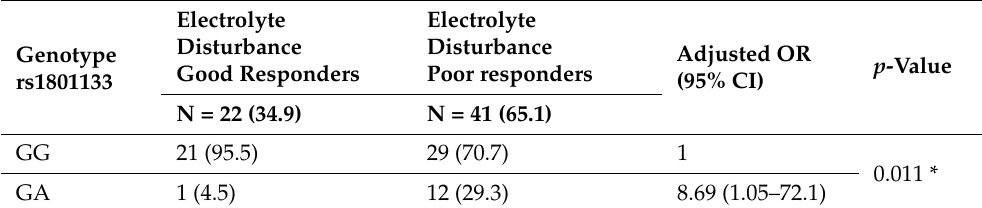
Table 8. Distribution of MTHFR genotype rs1801133 and electrolyte disturbances among good and poor ASM